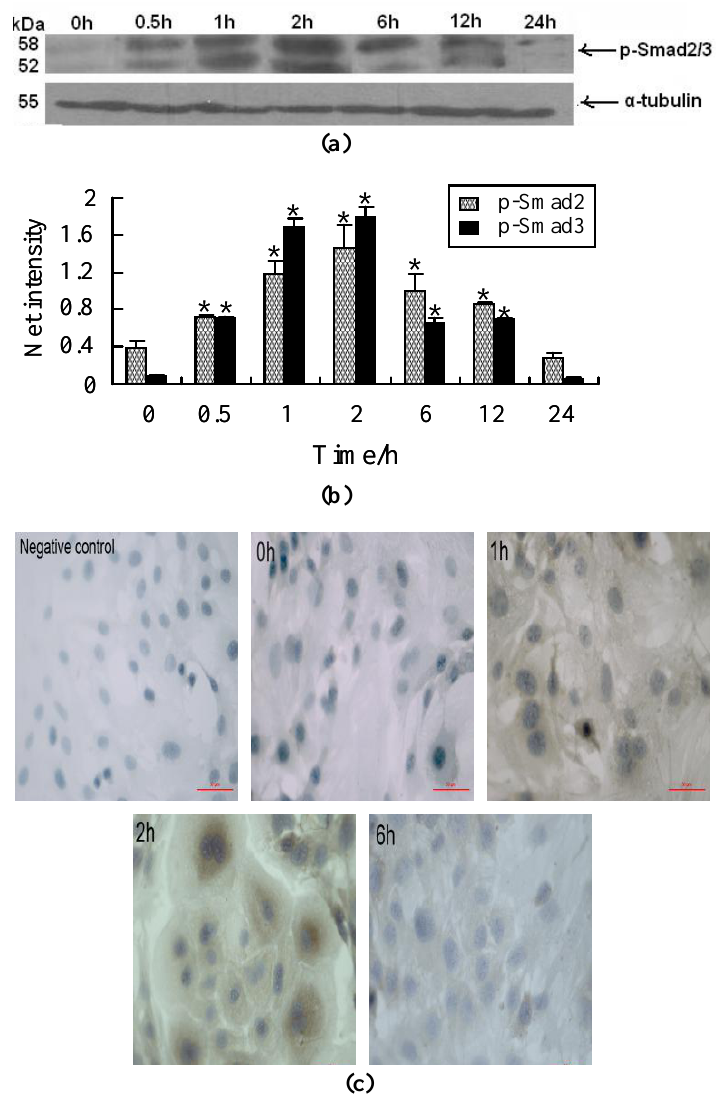
Figure 2. The expression of Smad2/3 within mammary epithelial cells treated with TGF-  1 . (a) The p-Smad2/3 express changes in mammary epithelial cells treated with TGF-  1 . (b) The expression of p-Smad2/3 within mammary epithelial cells treated with TGF-  1 . (c) The expression and location of p-Smad2/3 within mammary epithelial cells treated with TGF-  1 . * Indicates a significant difference between two groups